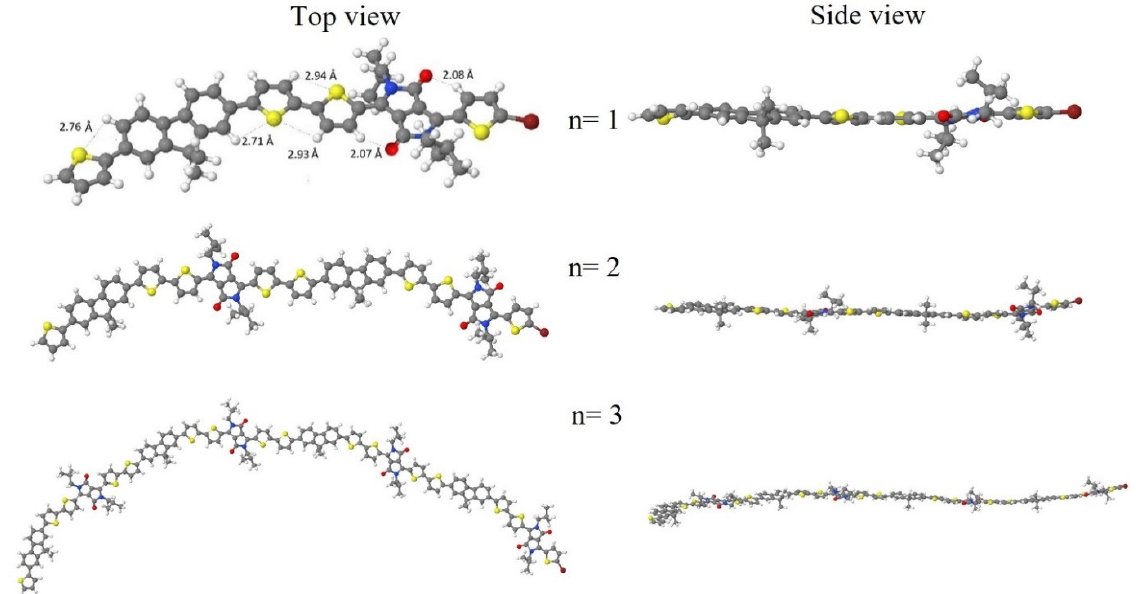
Figure 12. Experimental setup of the Z − scan technique in open aperture and Z − scan measurements at 1 mM of PFDPP-1 polymer.